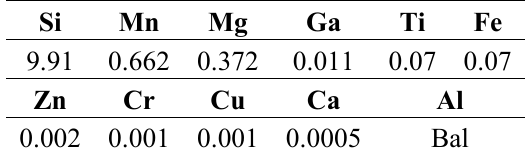
Table 3. Chemical composition of Silafont-36 alloy (wt.